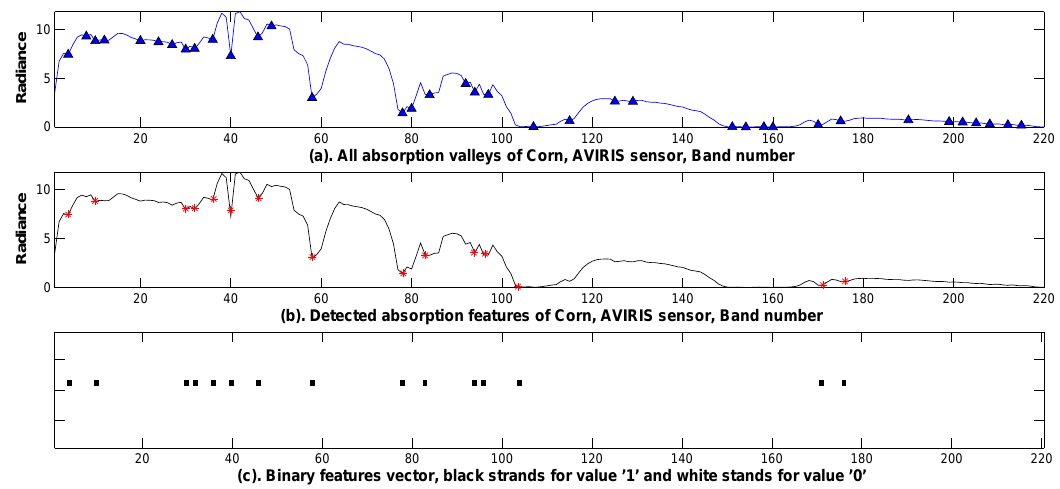
Figure 3. Absorption valley detection and the binary